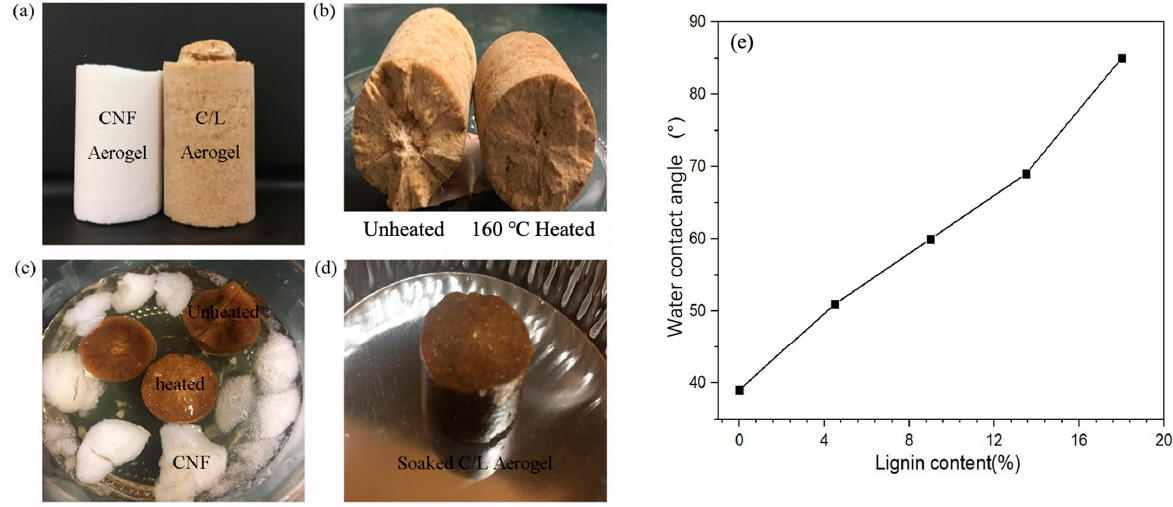
Figure 2. Photographic images of ( a ) CNF Aerogel and CNF/nano-lignin aerogel; ( b ) CNF/nano- lignin aerogels before and after heat treatment; ( c ) CNF and CNF/nano-lignin aerogels soaked in water for two hours; ( d ) CNF/nano-lignin aerogel after soaking; ( e ) contact angle of CNF aerogel and CNF/nano-lignin aerogels.